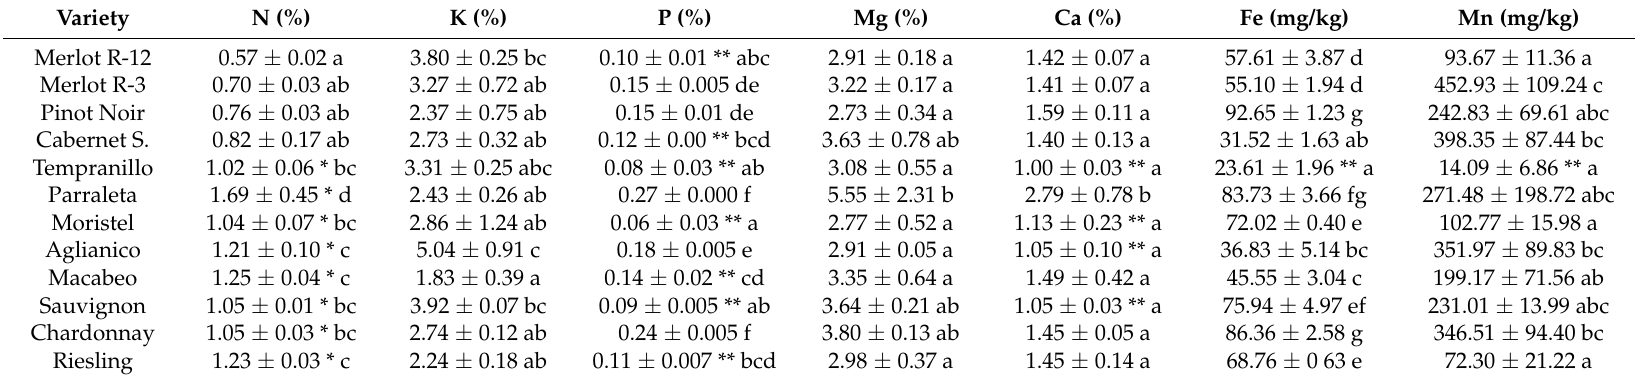
Table 4. Petiole analyses results (on dry weight) at the veraison stage for the different grapevine varieties.